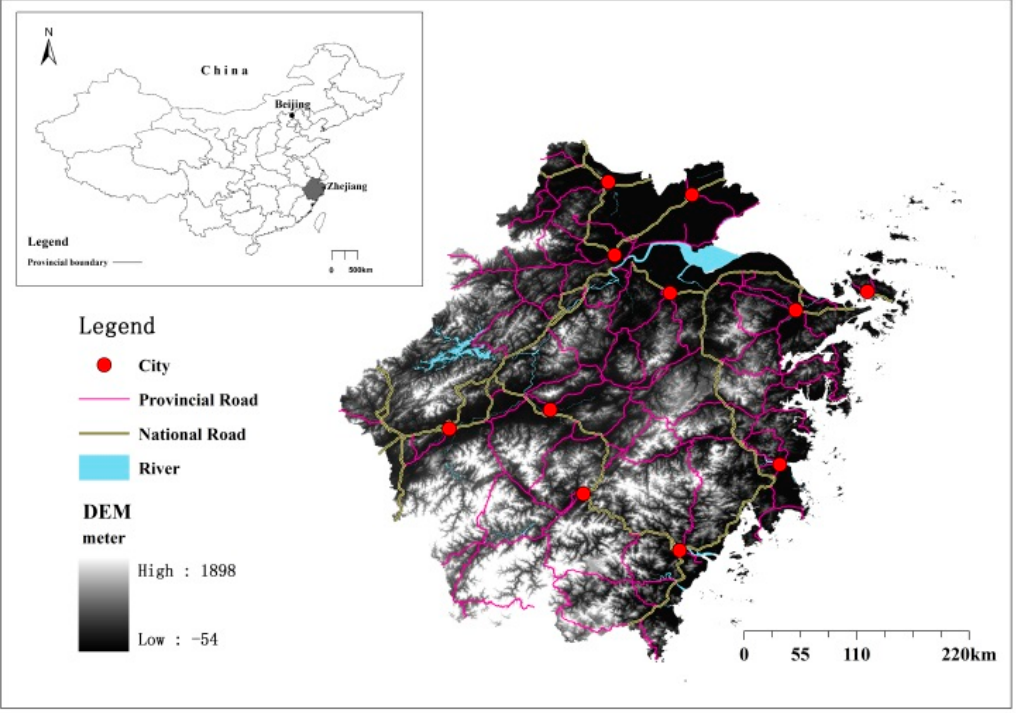
Figure 1. Location of the study area.